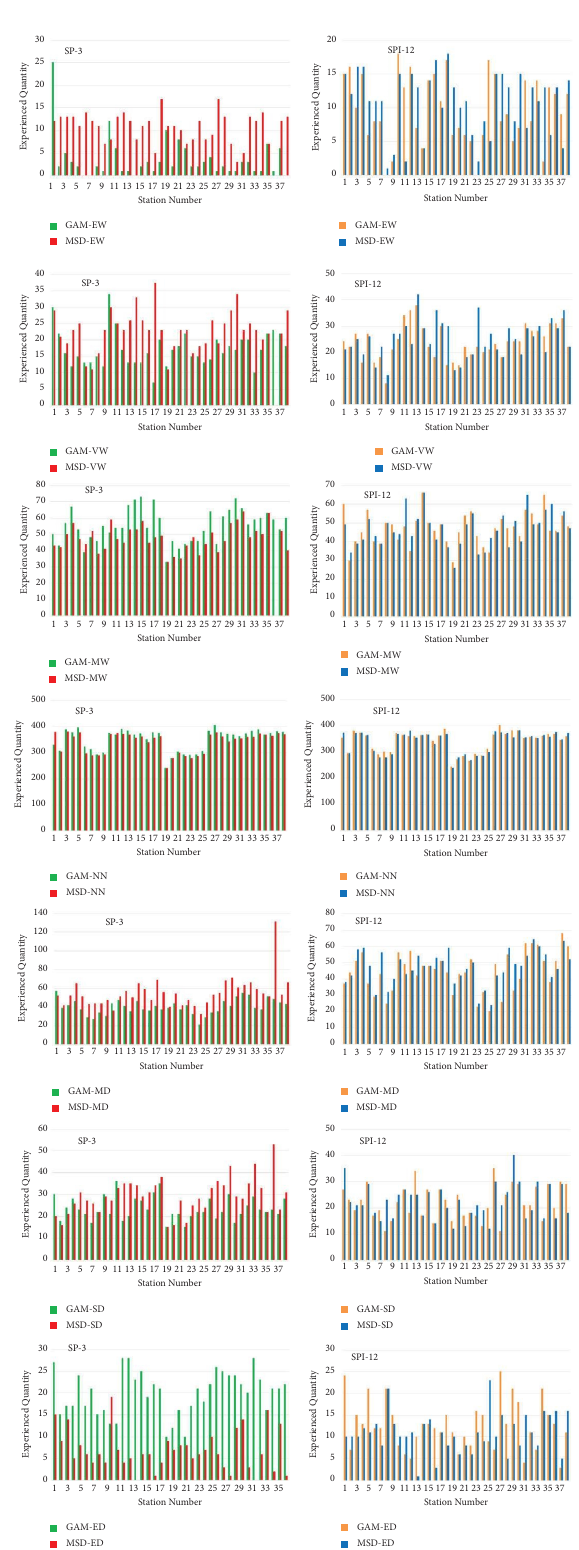
Figure 2: Comparison of SPI3 and SPI12 drought categories calculated based on Gamma distribution and Most Suitable